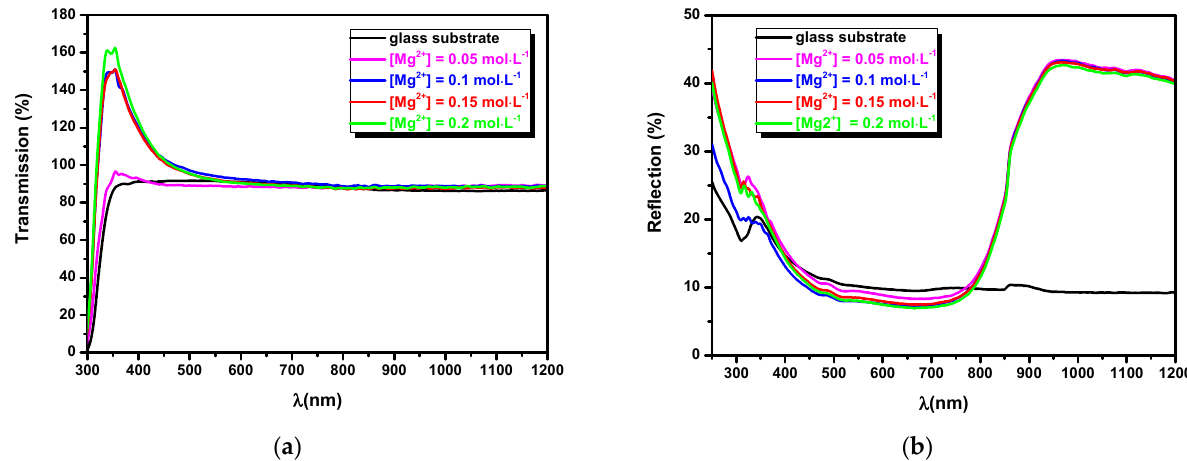
Figure 5. ( a ) Transmission and ( b ) reflectance spectra of sprayed MgO thin films grown for different concentrations [Mg 2 + ] = 0.05; 0.10; 0.15; and 0.20 mol·L − 1 .